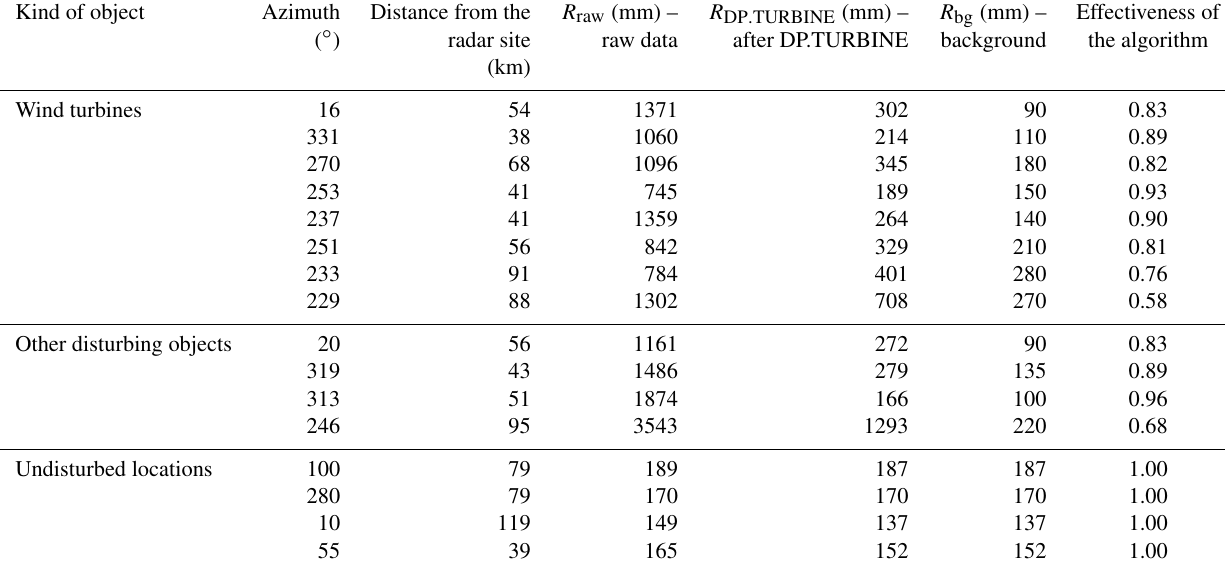
Undisturbed locations